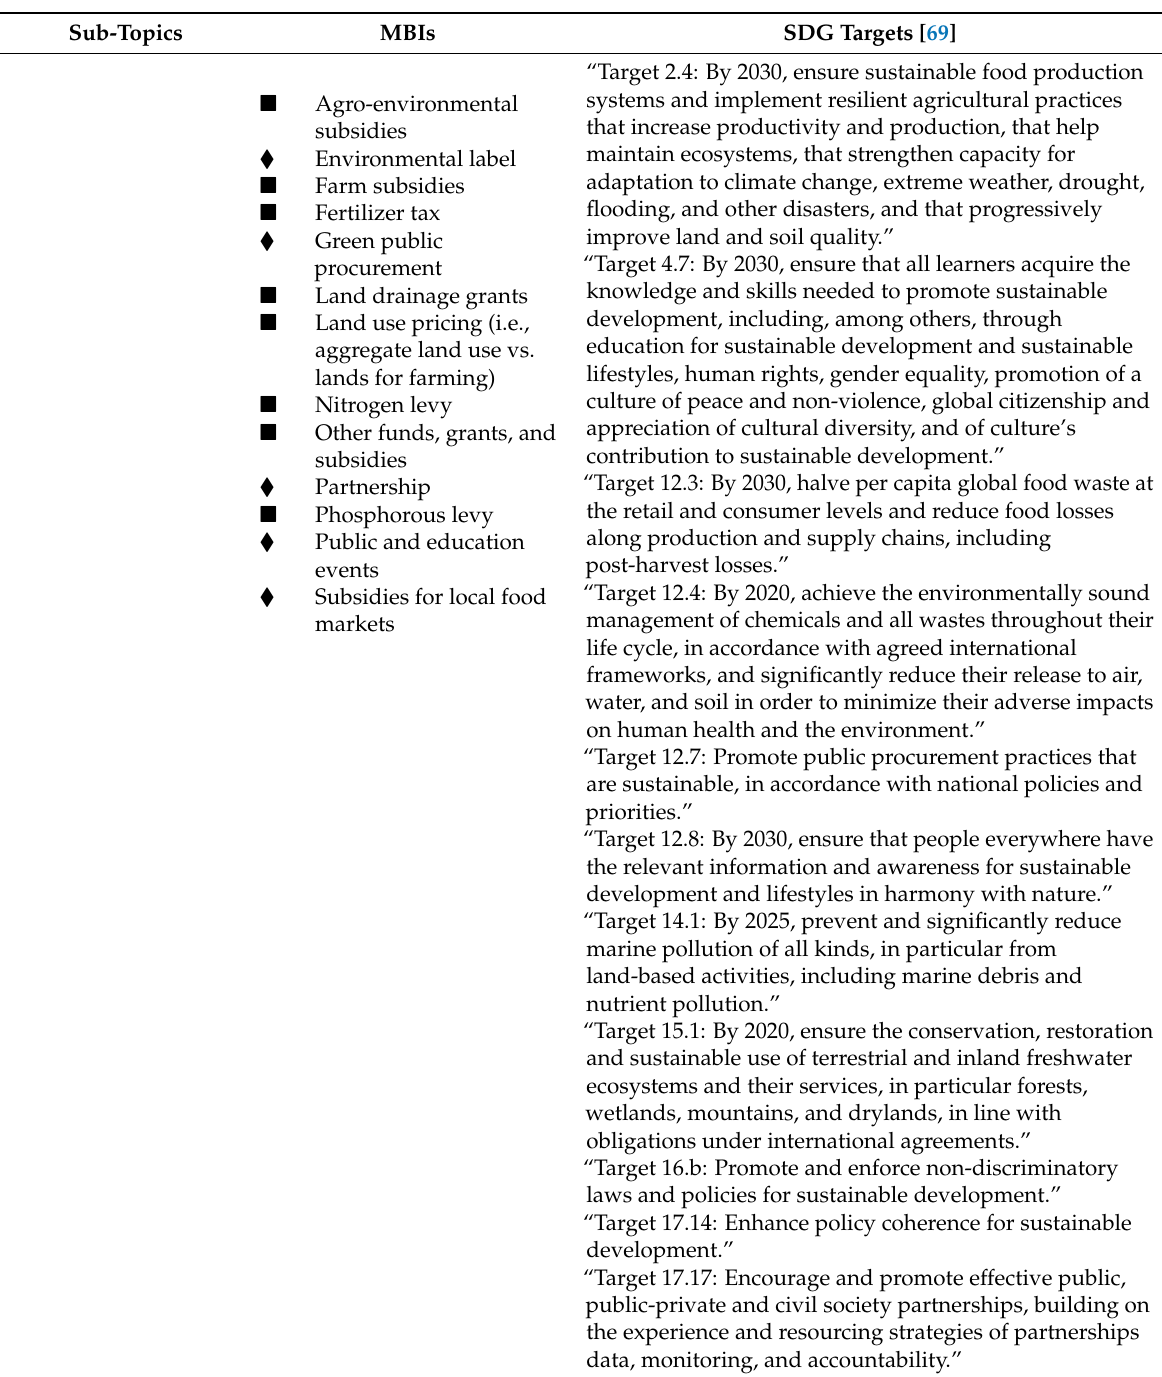
Table 9. Categorization of MBIs for Food Security and Related SDG Implementation.